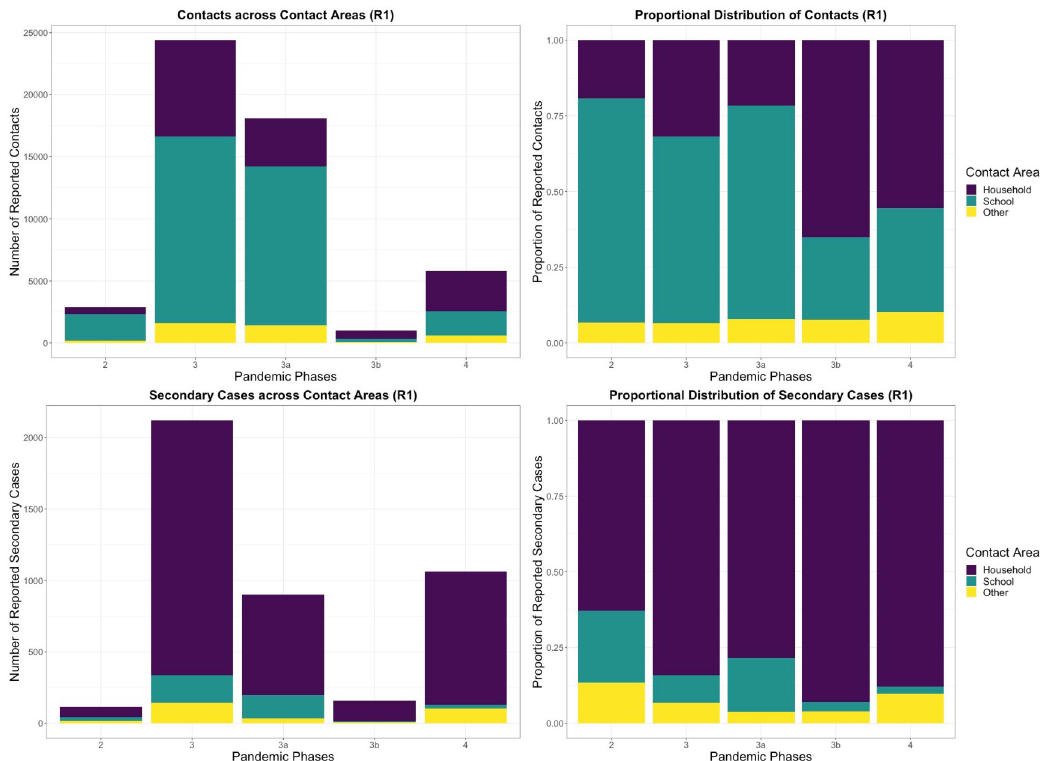
number of contacts (top right) and secondary cases (bottom right) and their change over time and policy environments are shown. Phase 2 represents open schools with low population incidence and low measures, phase 3a a time of high incidence and